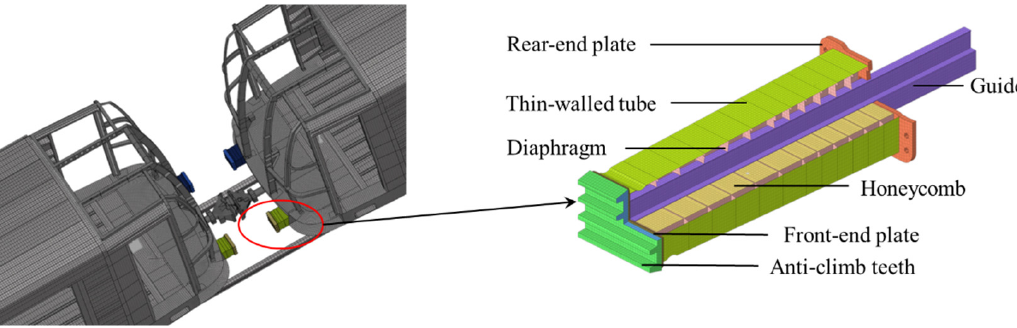
Figure 2. Schematic diagram of the square cone anti-climbing energy-absorbing structure.